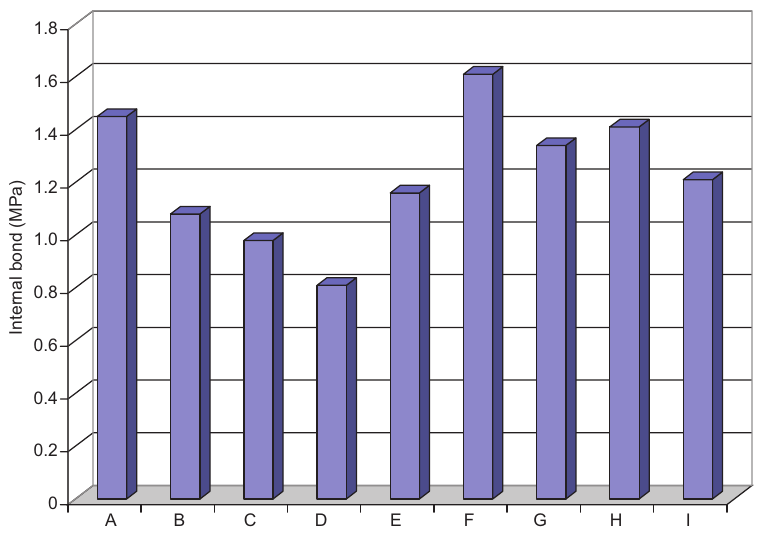
Figure 3 Internal bond strength of